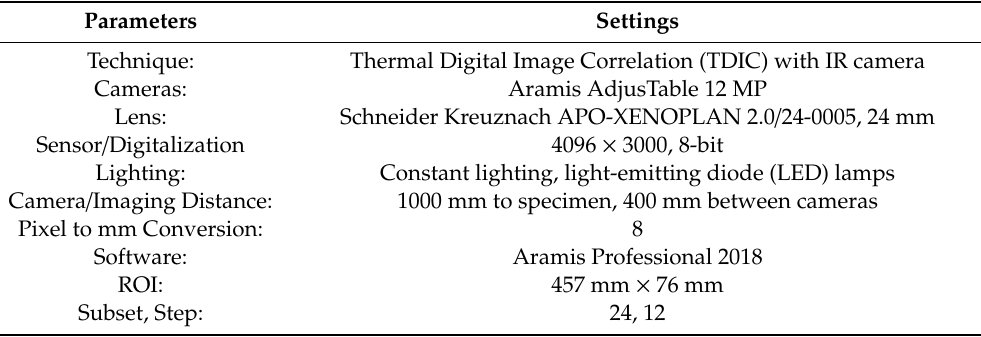
Table 3. Aramis stereo digital image correlation (DIC)